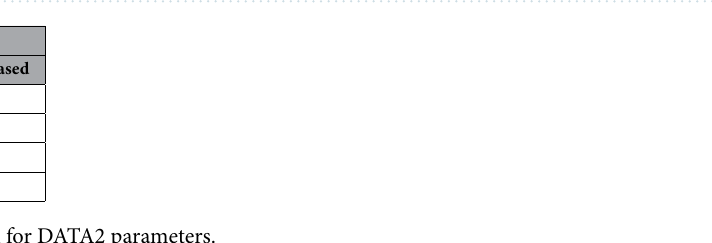
Figure 14. Classification results of DATA2 ( a ) LHV Compact-pol Decomposition, ( b ) LHV Raney Decomposition, ( c ) RHV Compact-pol Decomposition, and ( d ) Coherency Matrix.